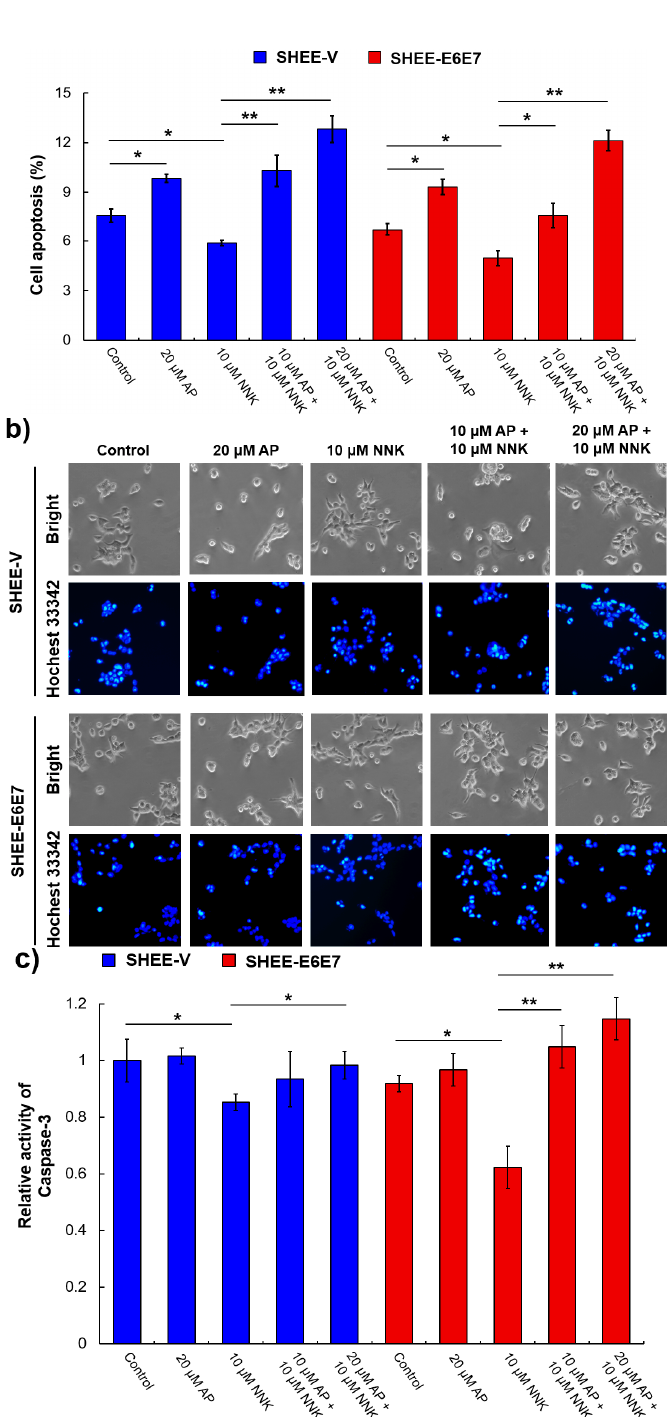
Figure 3. AP prevented anti-apoptosis of SHEE cells promoted by the synergism of NNK and HPV. ( a ) flow cytometry analysis for apoptotic cell number of SHEE; ( b ) photofluorography for validating the apoptotic SHEE cells; ( c ) caspase-3 activity of SHEE cells. Data are presented as mean ± SD (n = 3). * p < 0.05, ** p < 0.01.